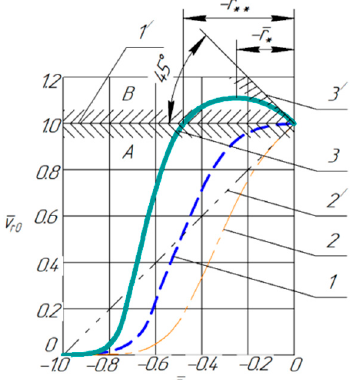
Figure 7. Changing the radial velocity amplitude over the radius of the droplet: A, B—zone of the constant and variable sign of the radial velocity gradient; 1–3—curves of the radial velocity amplitude; 1 / –3 / —tangential lines to the radial velocity at the droplet